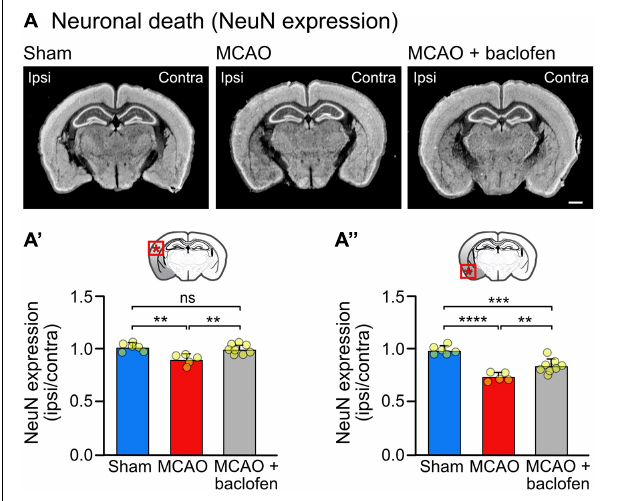
FIGURE 6 | Baclofen treatment after MCAO is neuroprotective. Mice were subjected to MCAO and injected with baclofen or saline followed by 6 h reperfusion. (A) Representative images depicting the expression of NeuN (scale bar, 1 mm). (A (cid:48) ) Quantification of the fluorescence intensities in the indicated area in the ipsilateral dorsal cortex normalized to the corresponding contralateral side. (A (cid:48)(cid:48) ) Quantification of fluorescence intensities in the ipsilateral ventral cortex normalized to the corresponding contralateral side. The data represent the mean ± SD of slices/mice obtained from: sham = 47/6; MCAO = 40/5; MCAO + Baclofen = 61/8). The data points represent the average fluorescence intensity derived from all slices analyzed per mouse. One-way ANOVA followed by Tukey’s Multiple Comparison test (ns, p > 0.05; **, p < 0.01; ***, p < 0.001; ****, p < 0.0001).